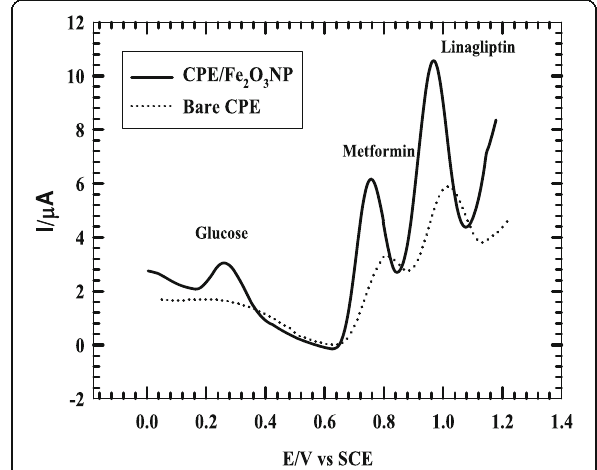
Fig. 7 SWV of B – R buffer solution (pH 7.4) containing LG with MET and glucose monitored at bare CPE and CPE/Fe 2 O 3